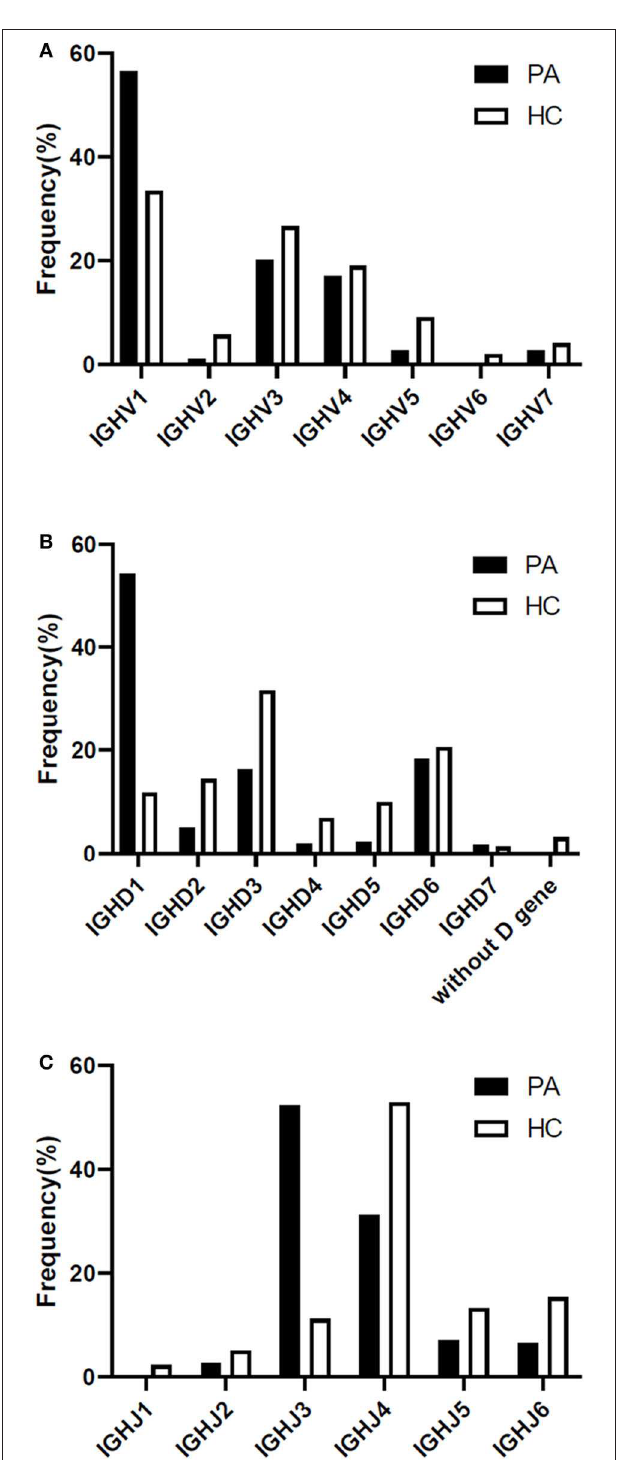
FIGURE 4 | Differences of heavy chain V-D-J gene family usage preference between the patients and 4 healthy Chinese persons (A-C) . PA: patient; HC: healthy control; IGH: immunoglobulin heavy